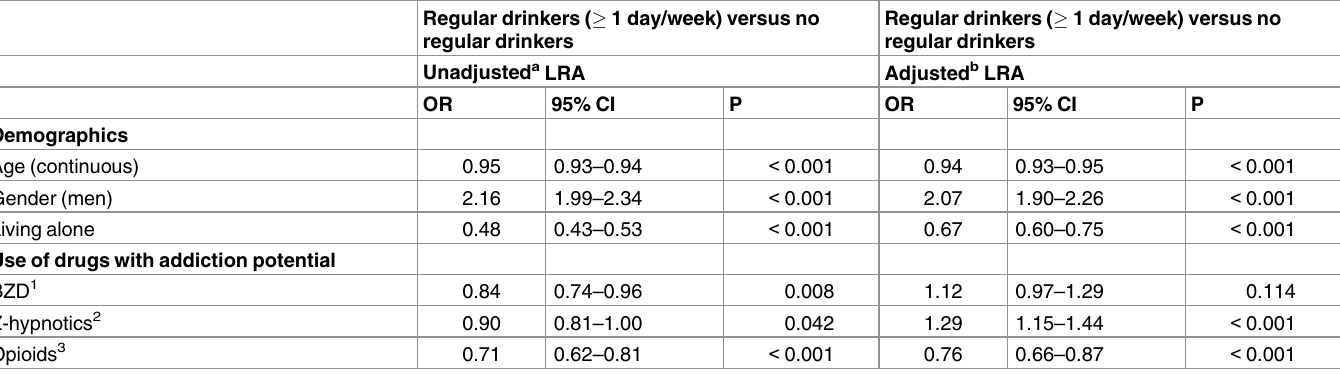
Table 3. Association between use of drugs with addiction potential and regular drinking ( (cid:21) 1 day/week) among older Norwegian adults ( (cid:21) 65 years, N = 11,545) in unadjusted and adjusted logistic regression analyses. The HUNT Study